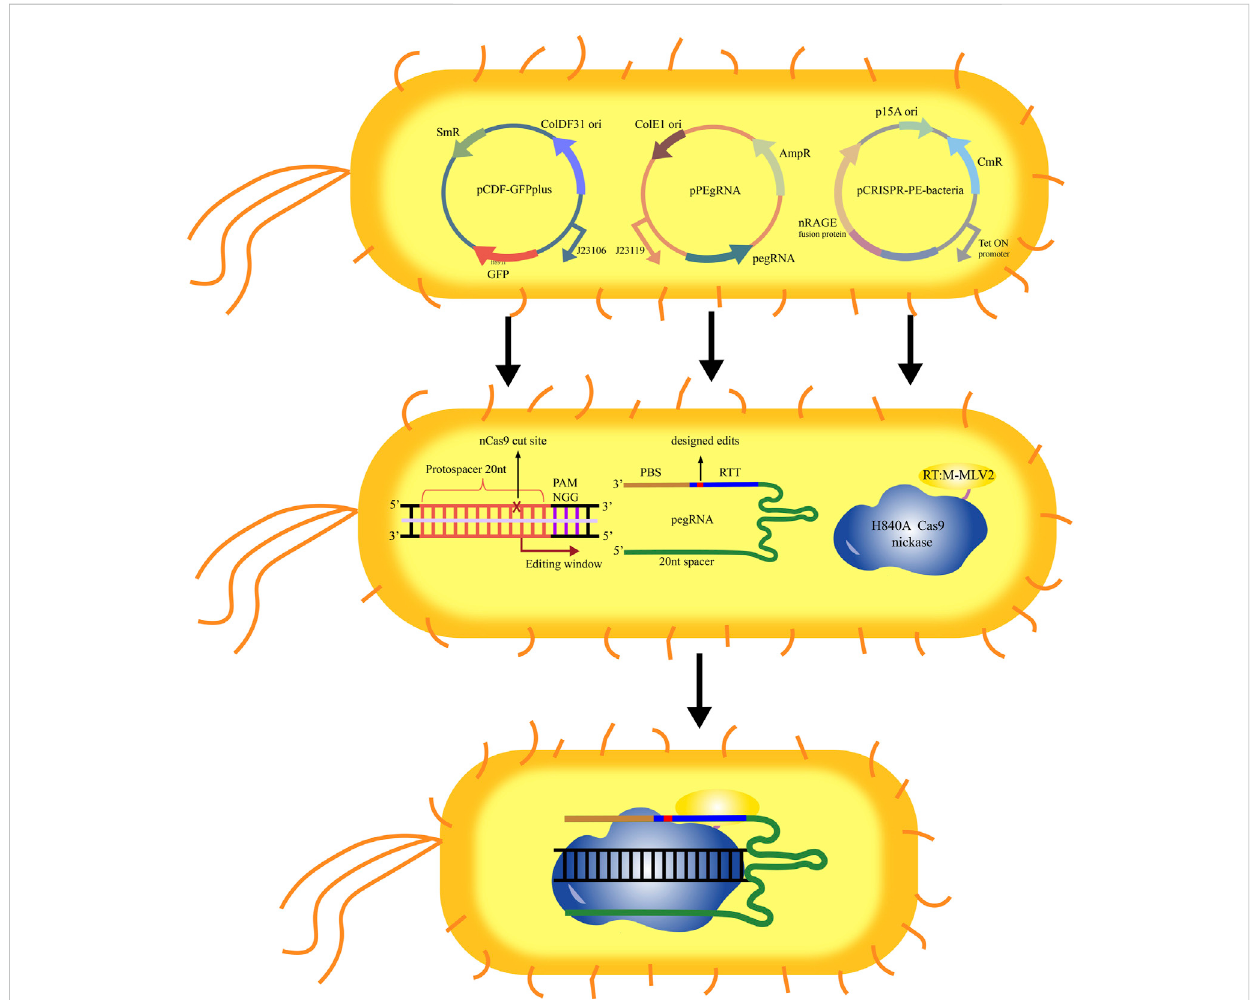
FIGURE 2 SchematicdiagramoftheoperatingprincipleofthePEsystemin E.coli .TheplasmidpCDF-GFPpluswasusedforexpressionof GFP, whichcouldbe used as the editing target. The plasmid pPEgRNA was used for expression of pegRNA. The plasmid pCRISPR-PE was used for expression of nCas9-M- MLV2. After introduced the three plasmids (pCDF-GFPplus, pPEgRNA, and pCRISPR-PE) into E. coli , the nCas9-M-MLV2:PEgRNA complex binds to the targetedsequenceguidedbysgRNA.ThePBSrecognizesandhybridizestothesinglestrandedDNA,andstartsthereversetranscriptionofnewDNA containing the designed edits based on the